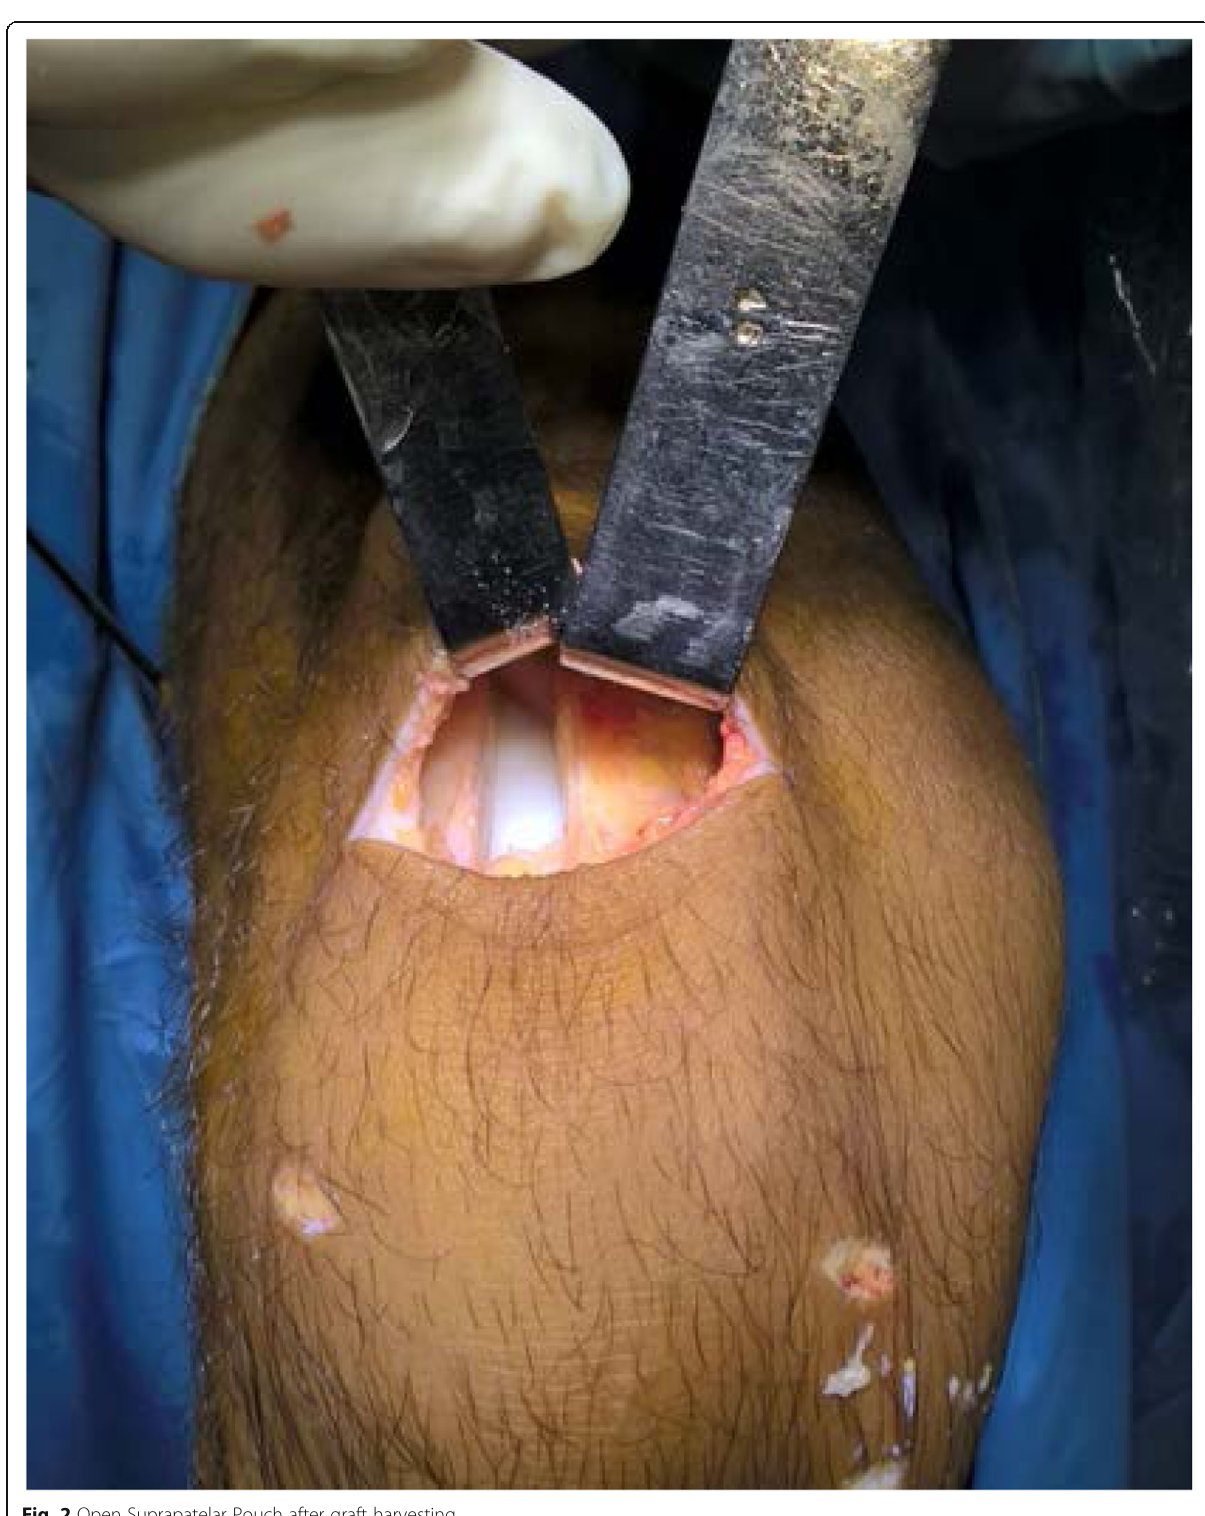
Fig. 2 Open Suprapatelar Pouch after graft